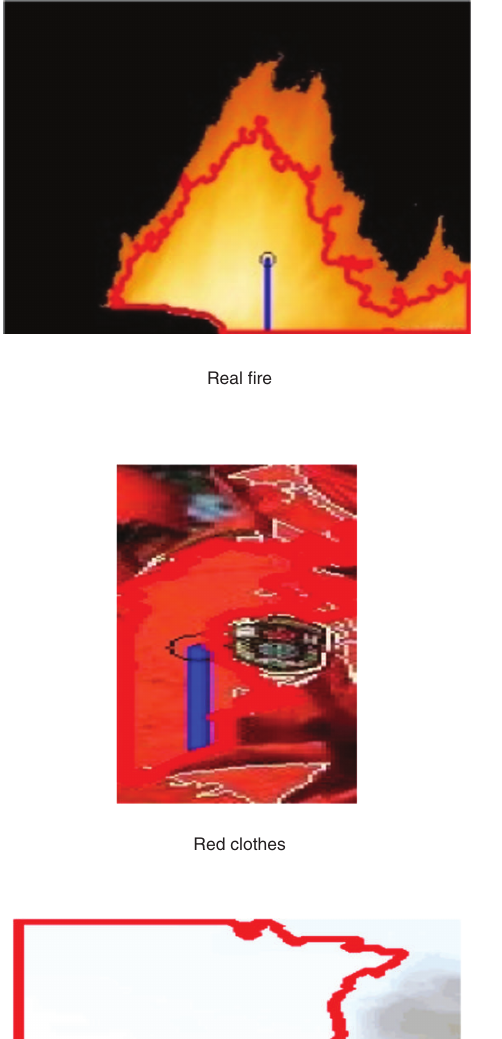
the pixel value of the flame region has a wider range compared with the flame-like region, which could be represented as variations of the gradient in eight directions. After calculating the distribution of color values in the RGB channels, the ratio of the mean probability density to the peak value was calculated based on probability density function